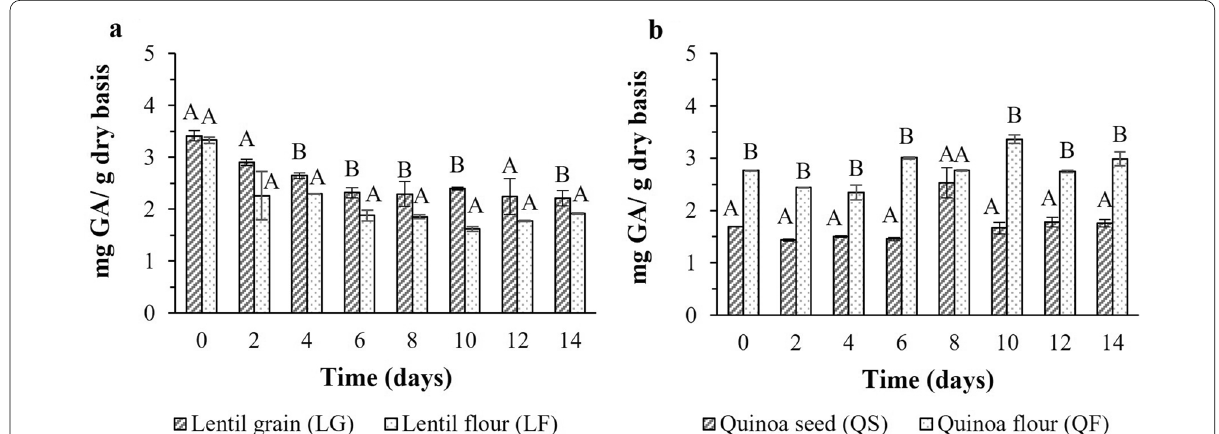
Fig. 3 Total phenol content in lentil grain and quinoa seeds and respective flours at different fermentation times. AB Capital letters indicate significant differences between grain/seeds and flour at the 95% ( p < 0.05) significance